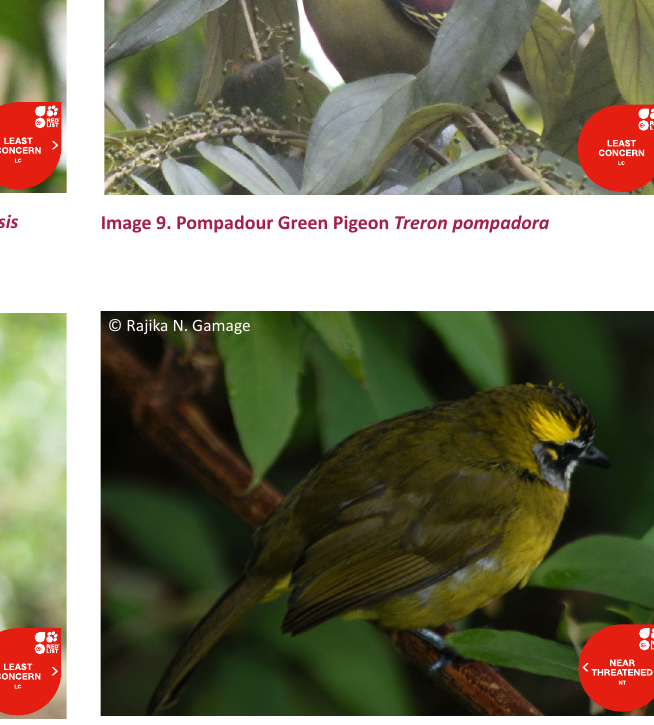
Image 10 Pied Bushchat Saxicola caprata